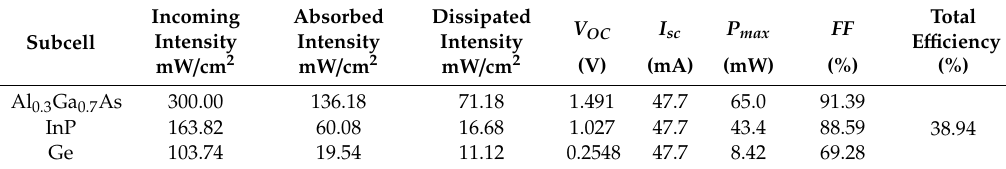
Table 2. Simulation results of TJSC at the geosynchronous orbit of Venus.